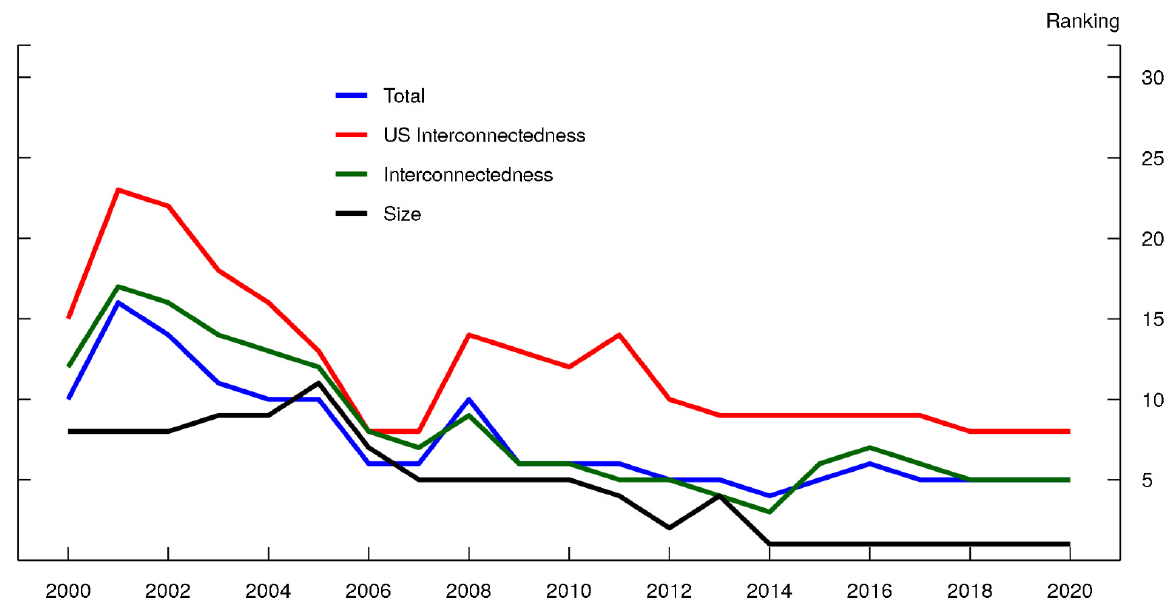
Figure 2. China’s systemic importance ranking. Sources: authors’ calculations based on information from the Bank for International Settlements, the IMF, and the World Bank.